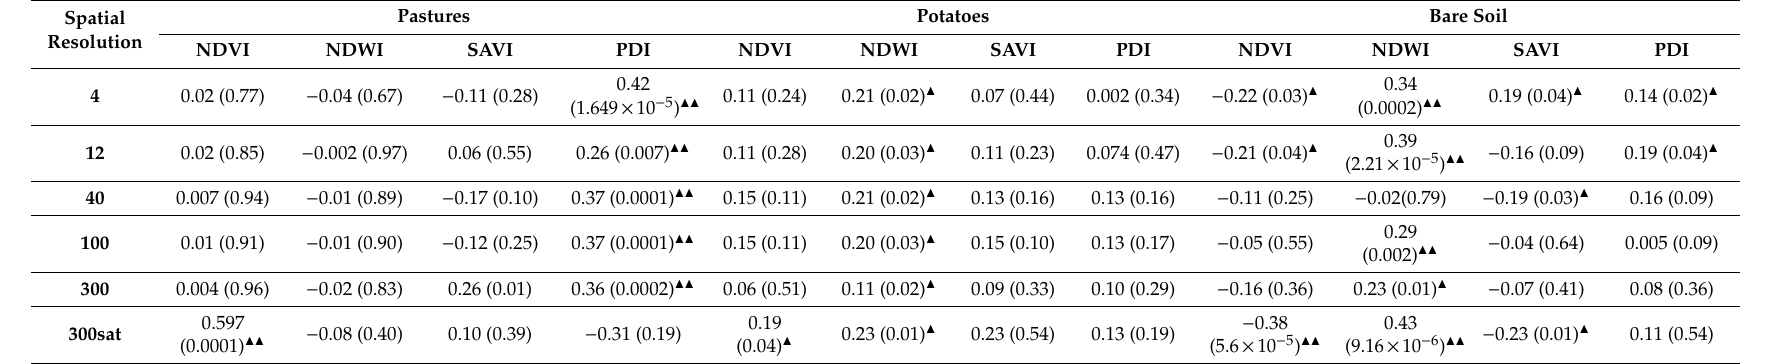
Table 4. Spearman’s correlation coe ffi cients (rho, p -value) for the normalized di ff erence vegetation index (NDVI), the normalized di ff erence water index (NDWI), the soil-adjusted vegetation index (SAVI), and the perpendicular drought index (PDI) regarding soil moisture at 0–10 cm depth under pasture, bare soil, and potatoes (n =